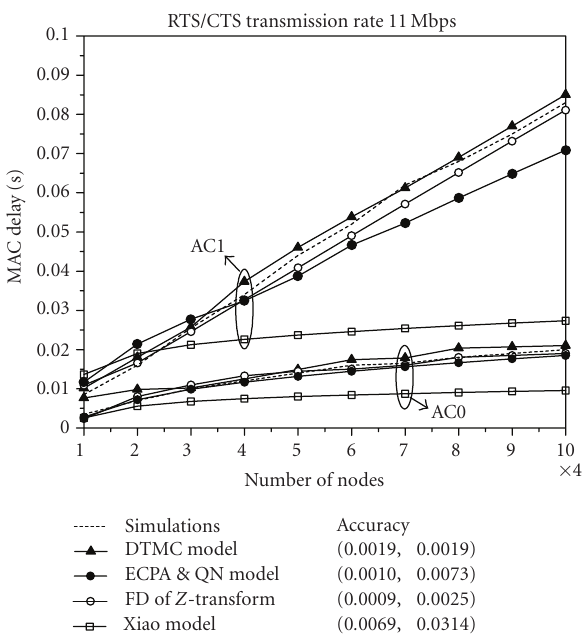
Figure 9: Analysis of MAC delay of the two higher ACs under satu- ration condition and RTS/CTS access mode.